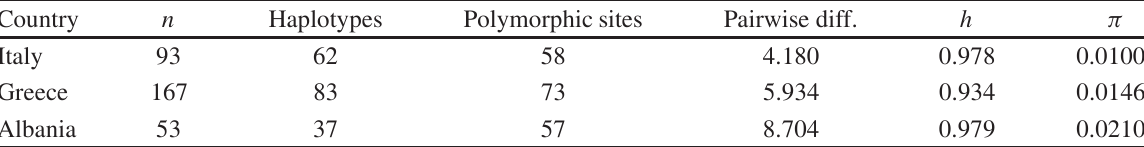
TABLE 2: Sample size per country ( n ), number of haplotypes observed (Haplotypes), number of polymor- phic sites, mean number of pairwise differences among sequences (pairwise diff.), haplotype diversity ( h ), and nucleotide diversity ( π ) are